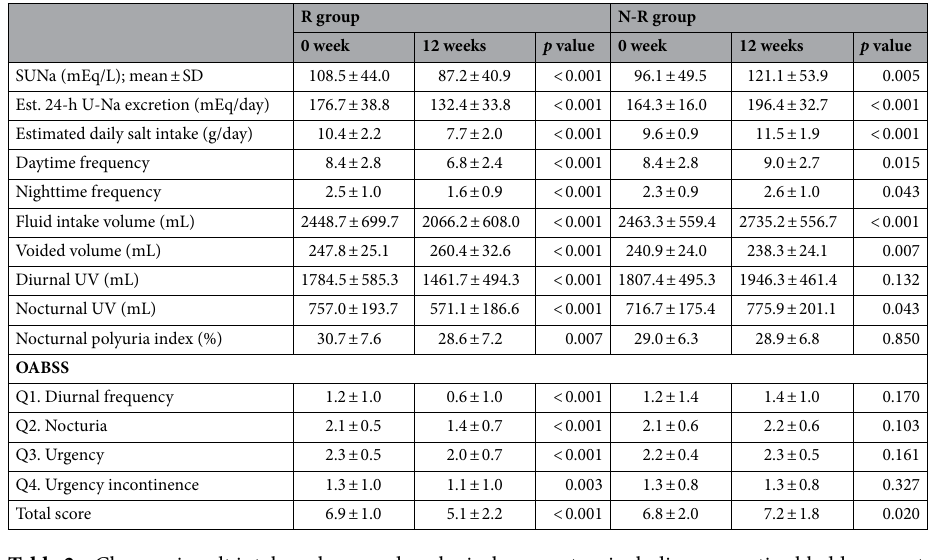
Table 2. Changes in salt intake volume and urological parameters including overactive bladder symptom scorer between two groups. R group restricted group, N-R group non-restricted group, SUNa Na concentration in the spot voiding urine, Est. 24-h U-Na estimated 24-h urinary Na, UV urine volume, OABSS overactive bladder symptom score, QI, Q2, Q3, and Q4 questions 1, 2, 3, and 4,